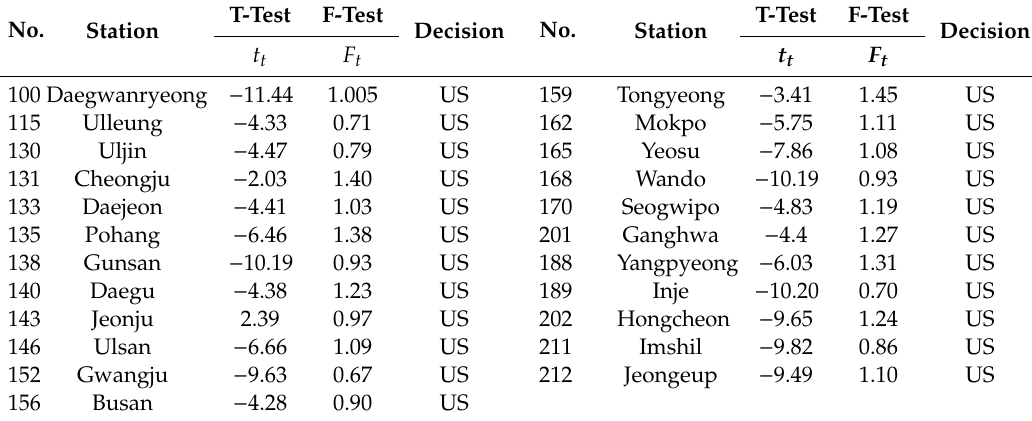
Table 8. Simple T-test and F-test analysis of annual precipitation using climate change scenarios.